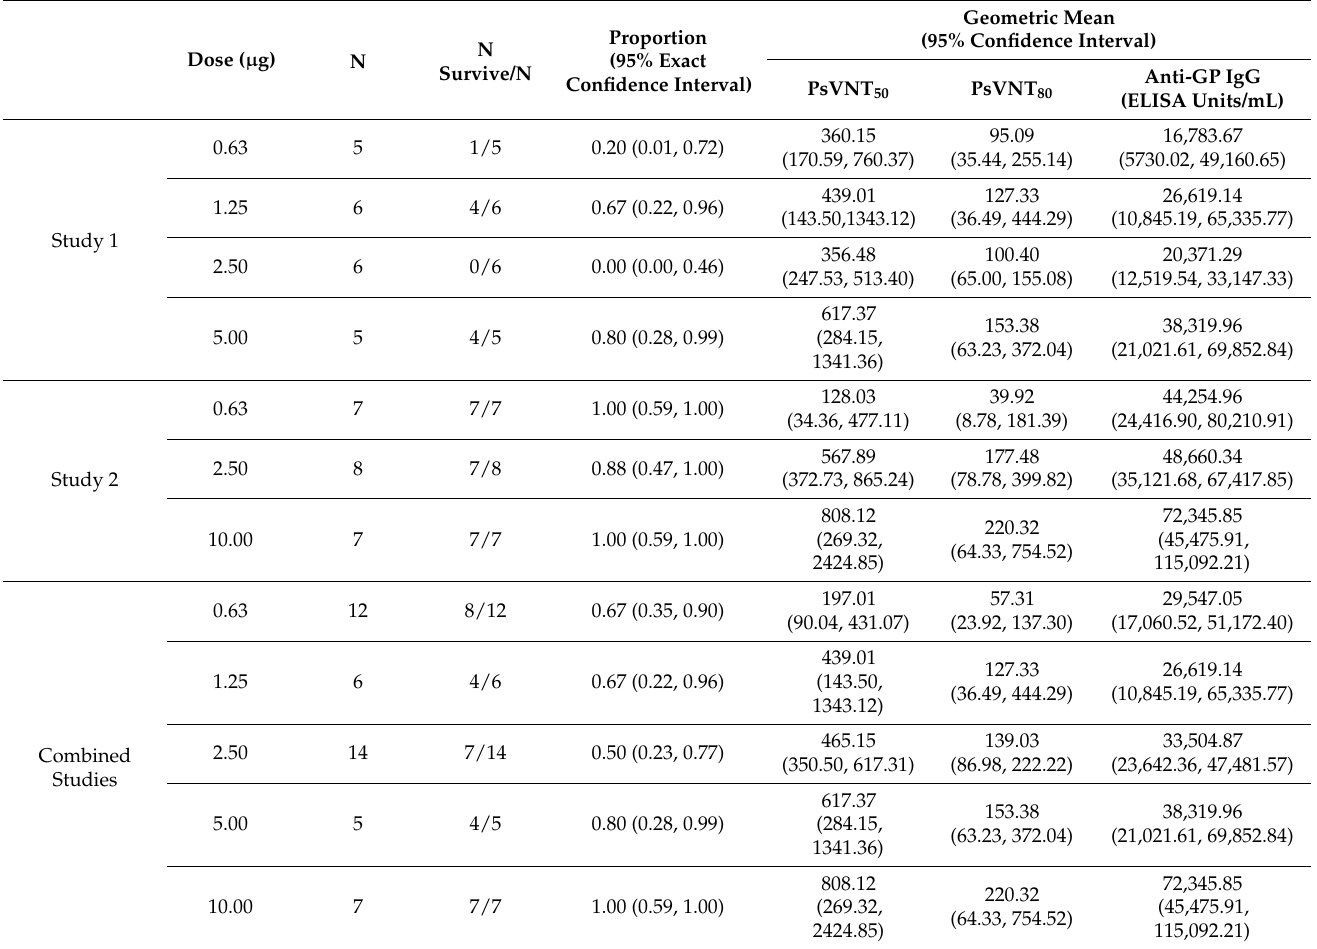
Table 1. Summary of survival and immune response by